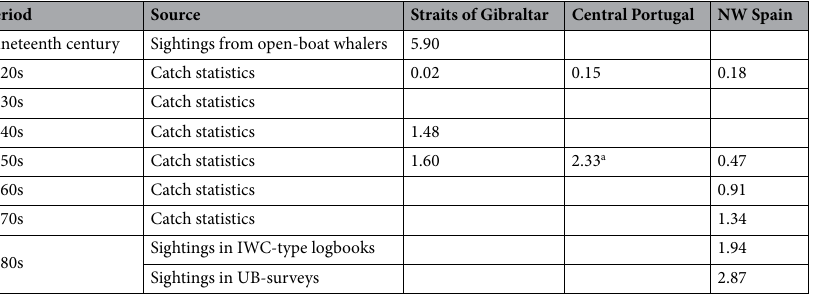
Table 3. Blue whale-fin whale catch and sightings ratios for different periods and areas in the SEAS ecoregion. The ratio is calculated as the number of blue whales caught or sighted per 100 fin whales caught or sighted (%). Data from the nineteenth century are collected from the literature 30 . a In the 1950s, whaling in central Portugal (Setúbal) was little active and statistics only include the catch of 43 fin whales and 1 blue whale 23 , so the ratio for this particular decade is considered little